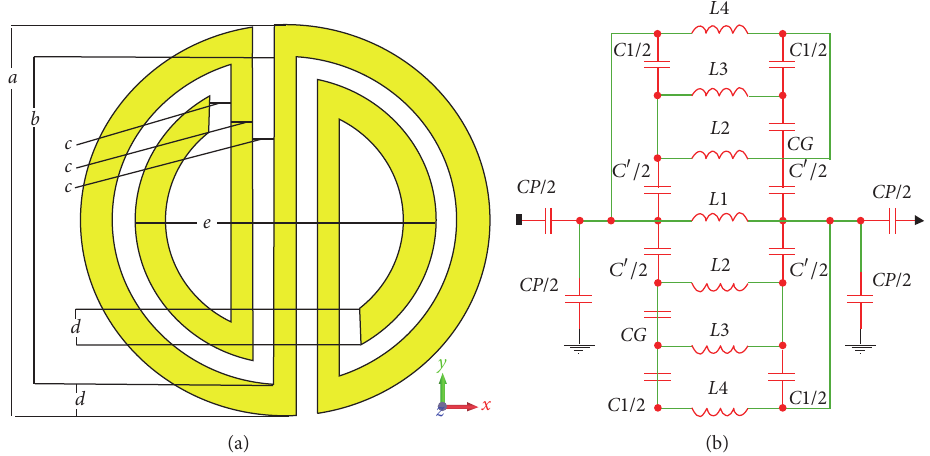
Figure 1: (a) The proposed unit cell with 𝑎 = 9.69 mm, 𝑏 = 8.78 mm, 𝑐 = 0.51 mm, 𝑑 = 0.93 mm, and 𝑒 = 8.25 mm. (b) Equivalent circuit model of proposed unit cell.